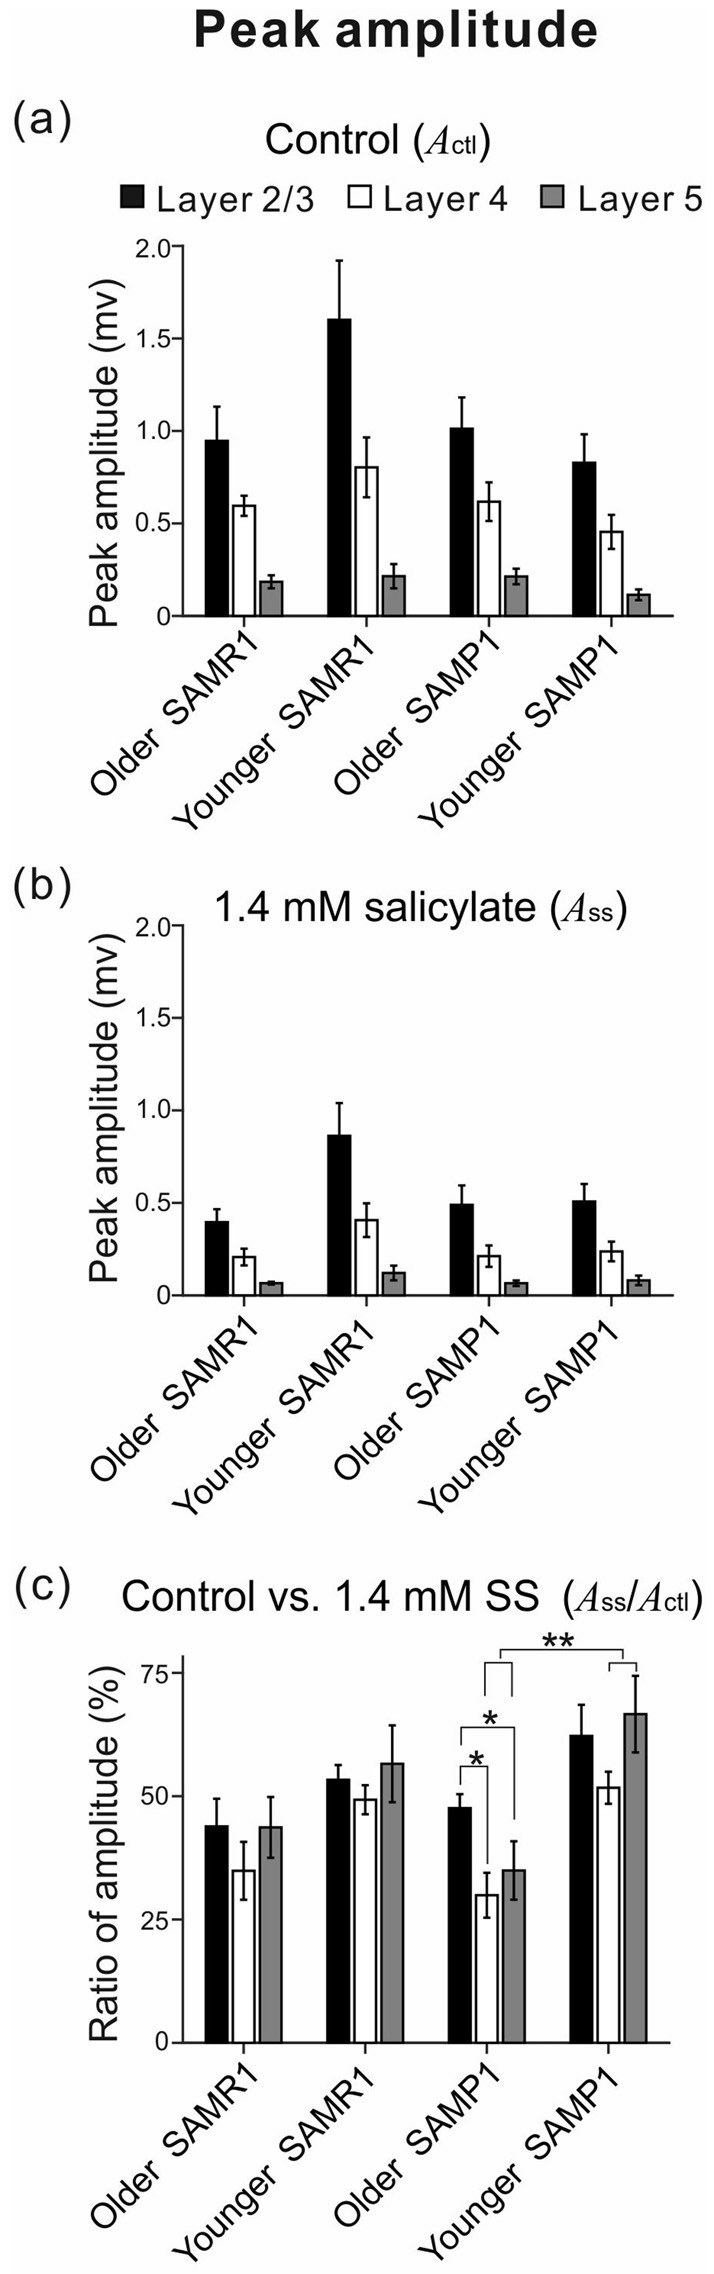
Among the four mouse groups (younger and older SAM-R1 and -P1), the peak amplitudes of stimulus-driven LFPs in the three layers (L2/3, L4 and L5) are shown before and after the SS superfusion. Peak amplitudes (Actl and ASS) in L2/3 (black), L4 (white) and L5 (gray) among the mouse groups are plotted under the control condition in (a) and the 1.4 mM SS superfusion condition in (b). The ratios of the amplitudes (ASS/Actl) among the four mouse groups are also illustrated in (c). Error bars represent standard error of the mean (SEM). Data are shown as mean ± SEM. *P < 0.05 and **P < 0.01 by the Tukey-Kramer multiple comparison test.